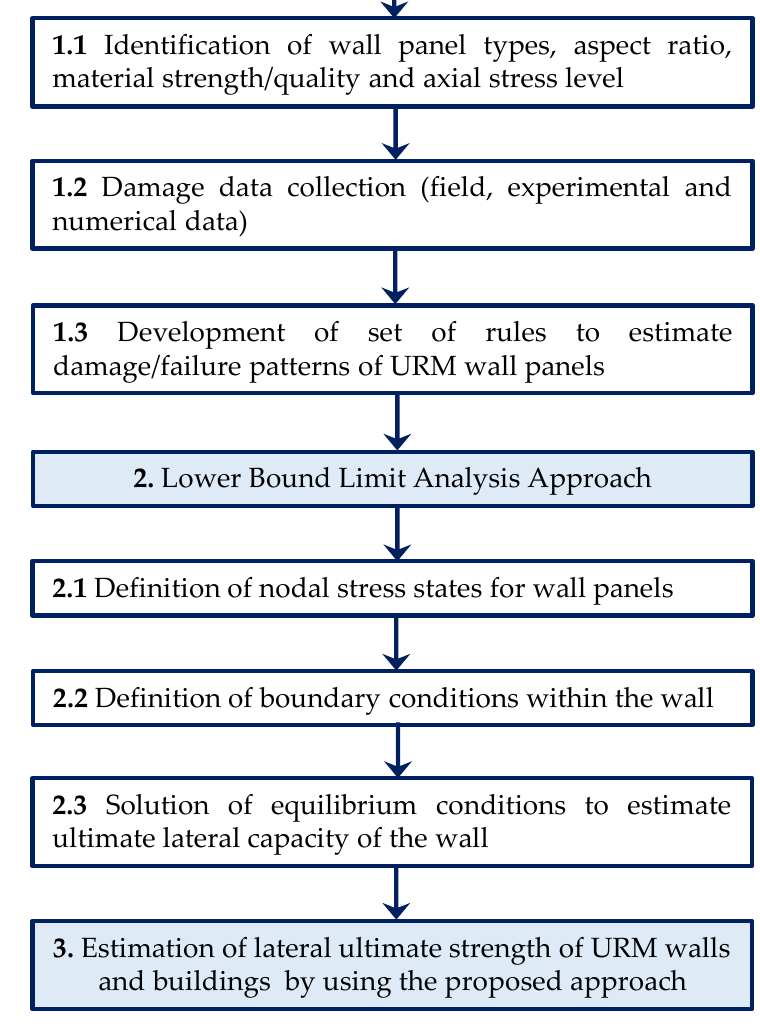
Figure 1. Flowchart of the proposed two-phase simplified approach.